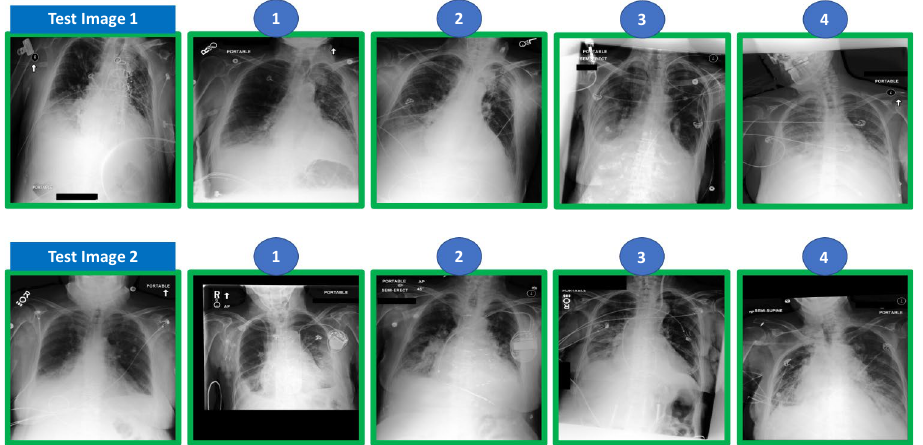
Figure 2. Example of test cases and ranking annotation for pleural effusion condition (the top 4 is shown) performed by the radiologist. The numbers on top of the image represent the ranking position of the image in the catalogue (when compared to the query/test image). The green box means pleural effusion case (according to the dataset